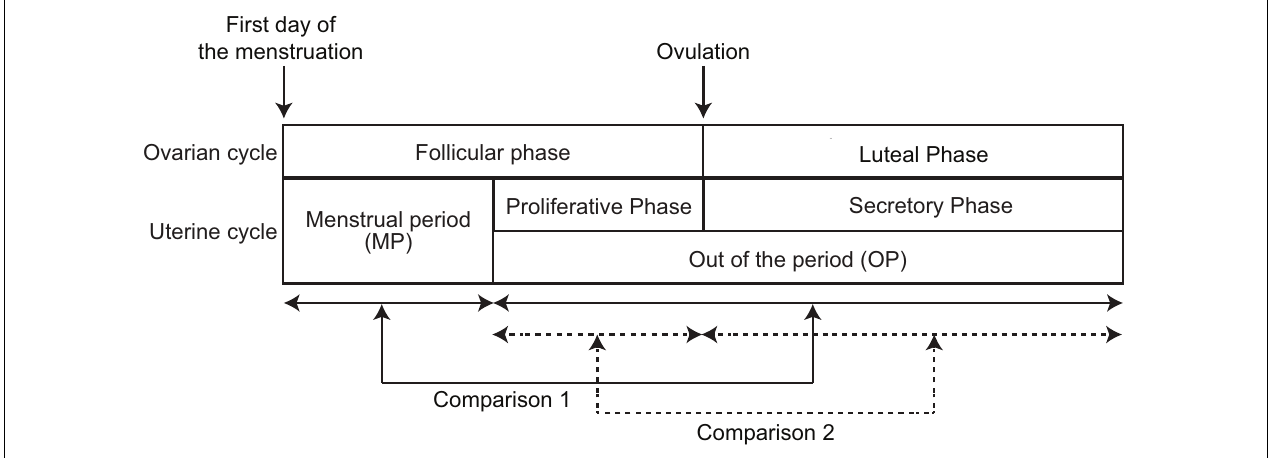
FIGURE 2 | Periods and phases of the menstrual cycle. The first row defines the ovarian cycle, whereas the second row defines the uterine cycle. One cycle includes two periods: the menstrual period (MP) and the period outside of menstruation (OP). The latter is further broken down into two phases: the proliferative and secretory phases. The follicular phase comprises the MP and proliferative phase, whereas the secretory phase is equivalent to the luteal phase. In the present study, neural activity was compared in two ways: (i) between the MP and OP (Comparison 1, solid arrows) and (ii) between the proliferative and secretory phases (Comparison 2, broken